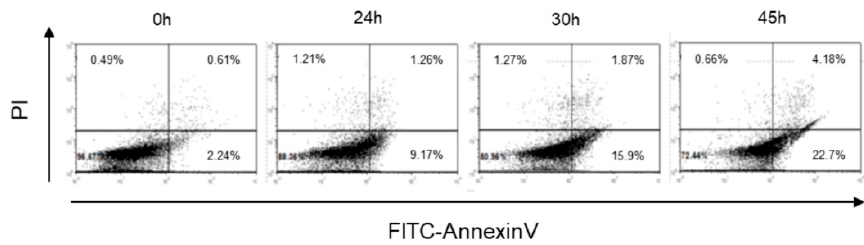
Figure 1. K 2 Cr 2 O 7 -induced apoptosis in HK-2 cells. Detection of apoptotic cells using Annexin V/propidium iodide (PI) at 24, 30, and 45 h.